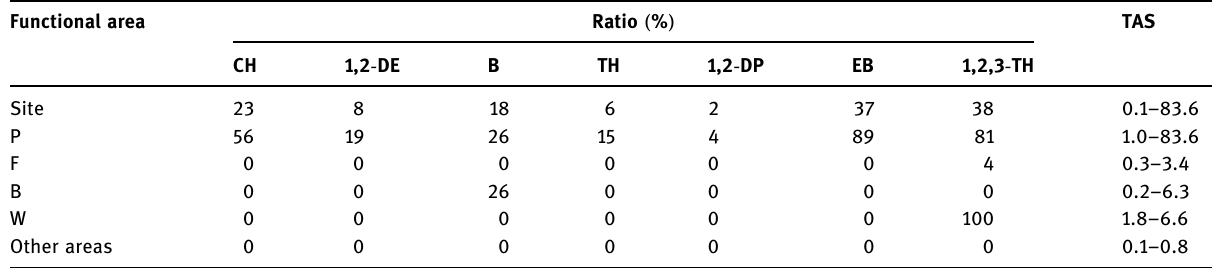
Table 3: AS (> 1.0 ) of VOCs in soil in the various functional areas of the chemical site Functional area